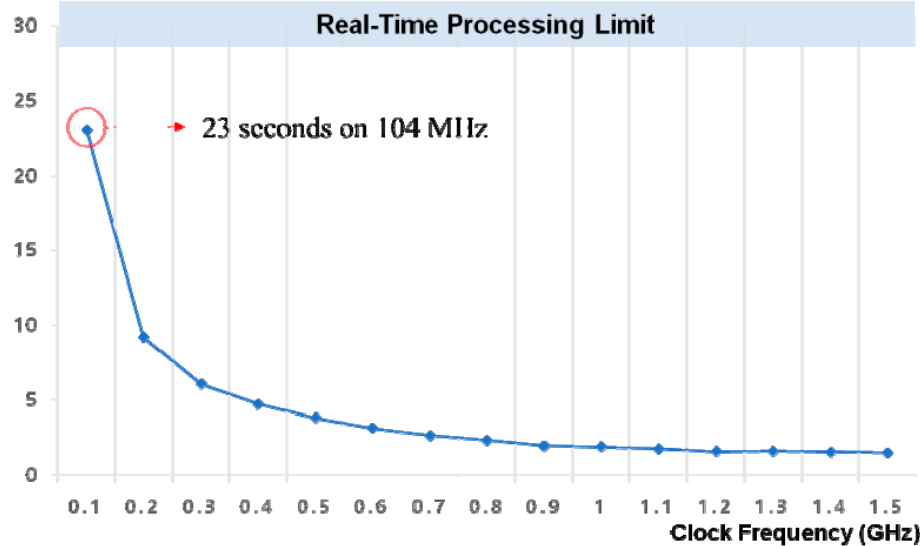
Figure 6. Performance of the real-time processing for sleep stage classification. The inference speed with O = 7, I = 14, W = 800 according to the clock frequency of the CPU core.